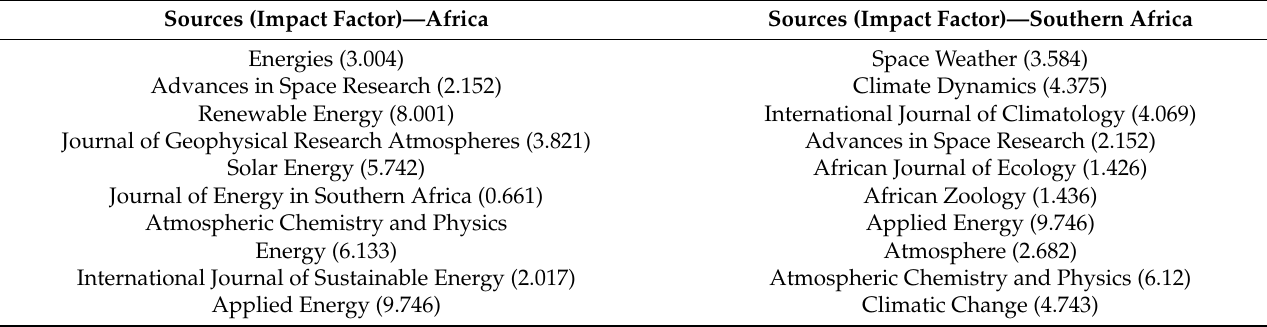
Table 4. The most relevant